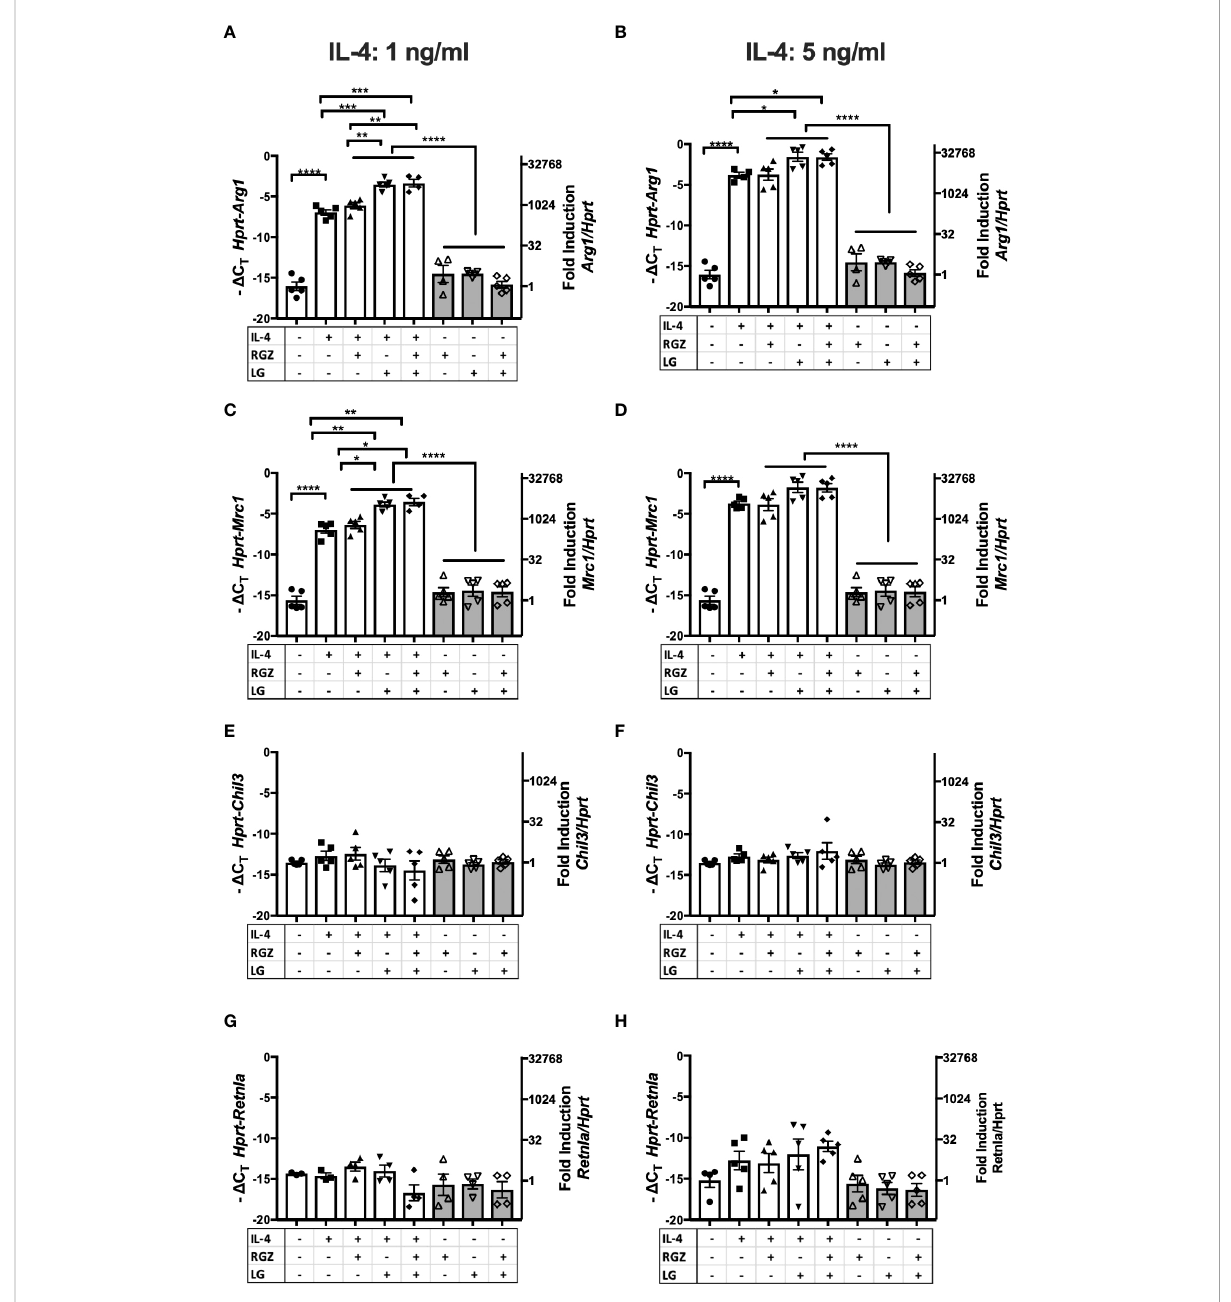
FIGURE 5 Effect of IL-4, PPAR g and RXR agonists on M2 macrophage gene expression using macrophages cell line MH-S. Murine alveolar macrophage cell line, MH-S was stimulated with IL-4 at different concentrations (A, C, E, G) 1 ng/ml; (B, D, F, H) 5 ng/ml) in the absence or presence of 1 µM of rosiglitazone (RGZ) (PPAR g ligand) and/or 1µM of LG100754 (LG) (RXR ligand) for 48 hr, and RNA was processed. Gene expression was quanti fi ed by qRT-PCR. Data were pooled from 3 independent experiments and is presented as - D C T (left y-axis) and fold induction (2 - DD CT value; right y- axis), mean ± SEM. Statistical analysis (one-way ANOVA with Tukey ’ s multiple comparison post-hoc test) was performed on the - D C T values. ****p <0.0001, ***p<0.001, **p<0.01, and